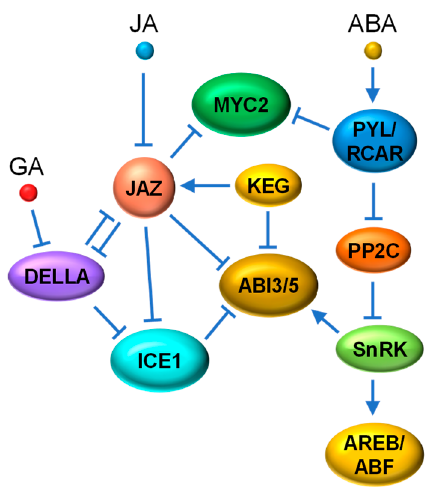
Figure 7. Simplified schematic of crosstalk between JA and ABA signaling pathways. The interaction between JAZ and ABI3 and ABI5 plays an important part in JA and ABA synergy. JA-mediated JAZ degradation releases ABI3 and ABI5, the positive TFs of ABA signaling. ABA also induces JA biosynthesis, which is thought to be mediated by the ABA-activated AREB/ABF TF members based on a recent study in rice. Antagonistically, the ABA receptor PYL6 interacts with MYC2 and negatively regulates its activity in an ABA-dependent manner. KEG acts as a negative regulator of both JA and ABA signaling by stabilizing JAZ12 and triggering ABI5 degradation. The transcriptional activity of ABI5 is also repressed through physical interaction with ICE1. ICE1, as a negative regulator of ABA signaling, is repressed by DELLA proteins of the GA signaling pathway. ABI5, ICE1, and DELLA proteins are also targets of JAZ proteins. PYL/RCAR, PYRABACTIN RESISTANCE/REGULATORY COMPONENT OF ABSCISIC ACID RECEPTOR; PP2C, type 2C protein phosphatase; SnRK2, SNF1-related kinases2; ABI5, ABSCISIC ACID-INSENSITIVE5; AREB/ABF, ABA-RESPONSIVE ELEMENT BINDING PROTEIN/ABRE-BINDING FACTOR; KEG, KEEP ON GOING.